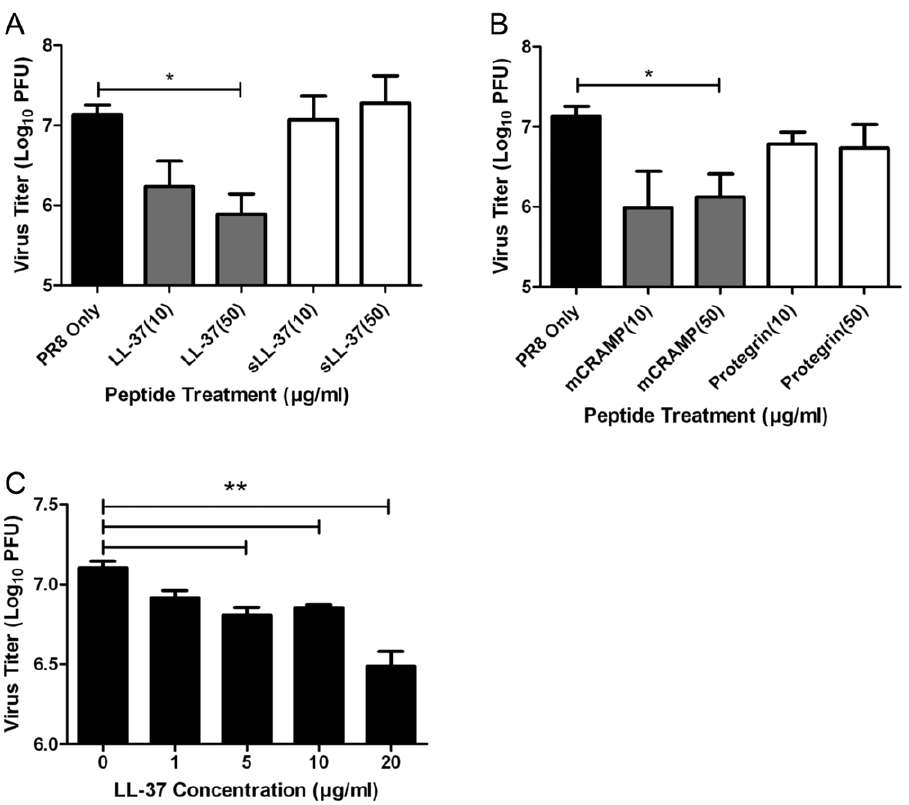
Figure 4. Cathelicidins show antiviral activity against influenza virus invitro. Influenza virus was pre-incubated with cathelicidin peptide or control peptide scrambled LL-37 (sLL-37) (A) at a range of concentrations as indicated for 1 hour at room temperature and a plaque formation assay was then performed to assess virus titer in MDCK-L cells in the presence of trypsin. Viruses used were A/PR/8/34 (H1N1) (A, B) or A/Udorn/307/72 (C). The antiviral activity of the cathelicidins LL-37 (A, C), mCRAMP (B) and Protegrin-1 (B) was assessed. Figures are representative of at least three independent experiments. Figures show mean values 6 SEM. Statistical analysis was performed using an unpaired t-test to compare virus only titer with virus + peptide (*P # 0.05, ** P # 0.01).